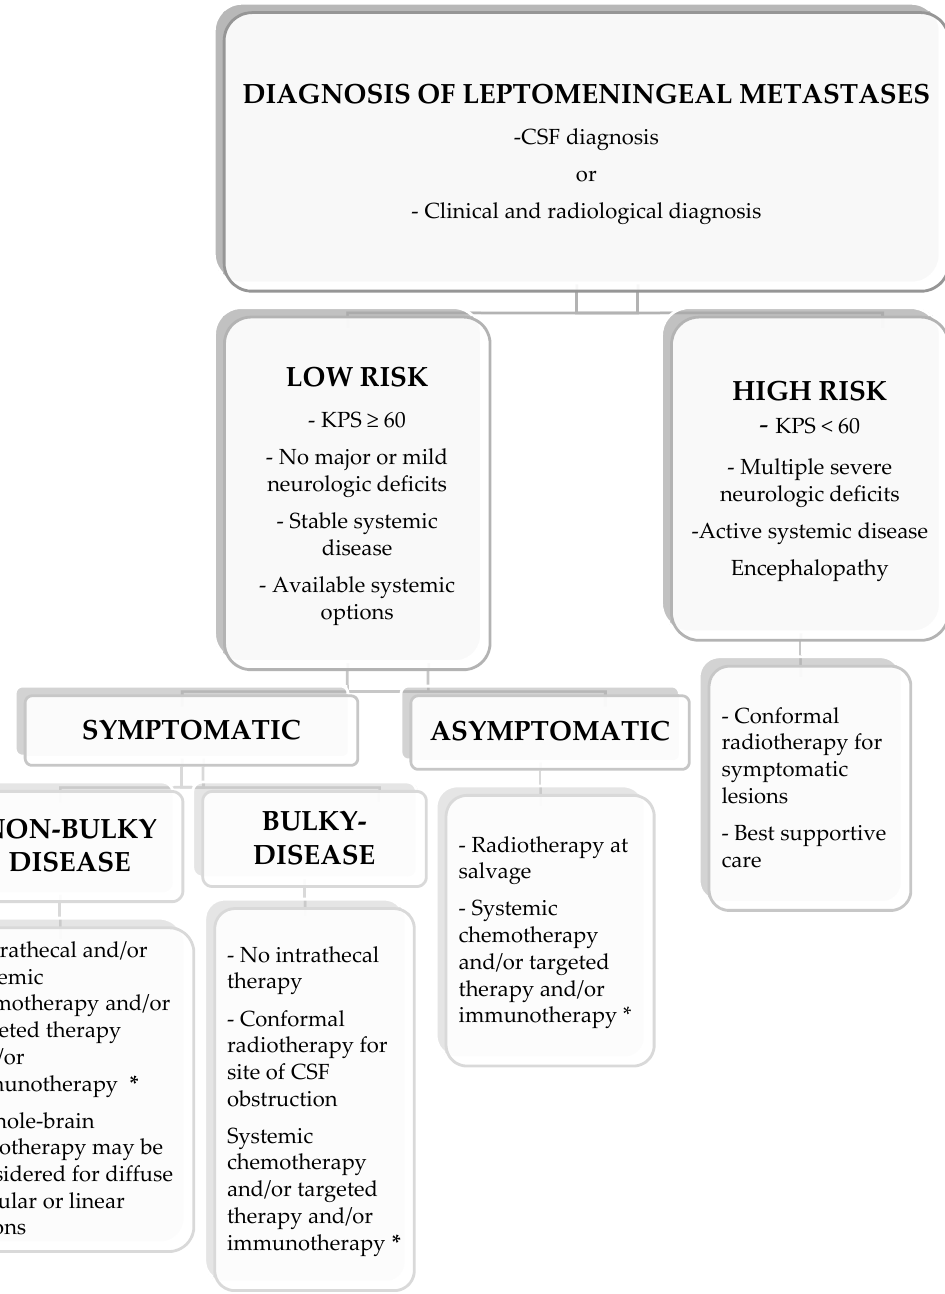
Figure 4. Treatment decision algorithm for leptomeningeal metastases. * Based on druggable mutations or PD-L1 expression.